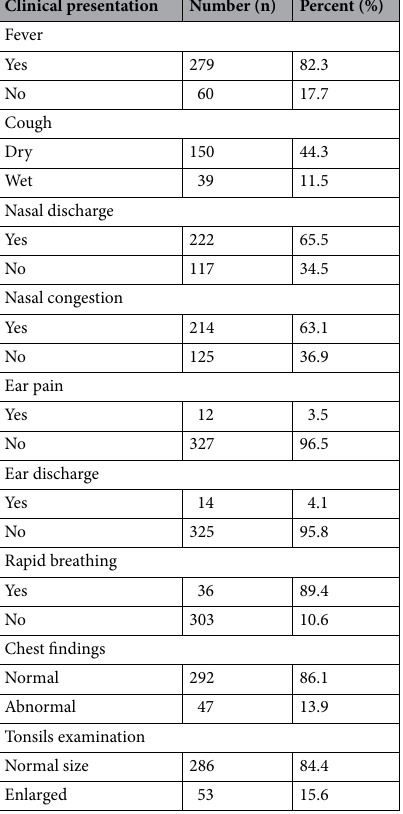
Table 2. Clinical presentations of upper respiratory tract infections.